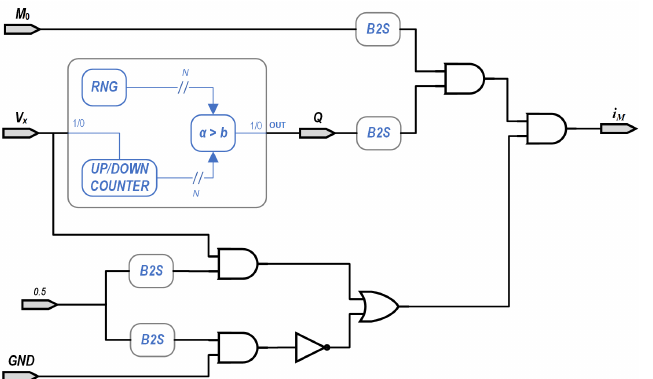
Figure 6. The Stochastic Computing memristor implementation. Inputs v x and GND are the SCN values of the positive and negative inputs of the memristor, respectively, and i M is the calculated SCN value of the